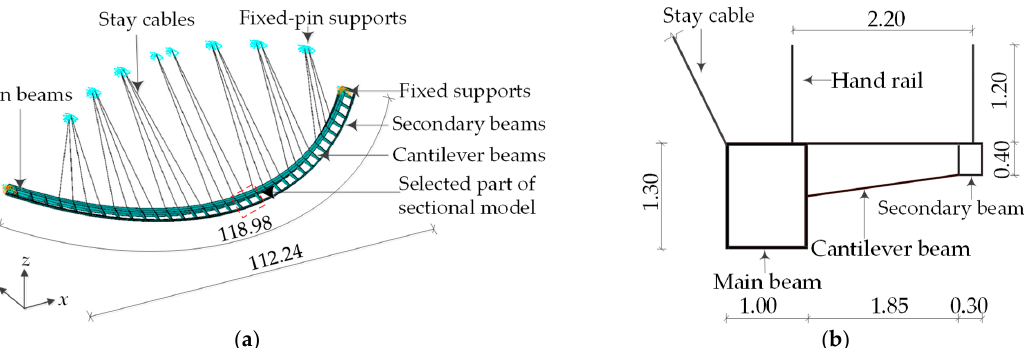
Figure 1. Diagram of curved beam unilateral stayed bridge (Unit: m). ( a ) Overall diagram of glass landscape bridge, ( b ) Bridge cross-section.